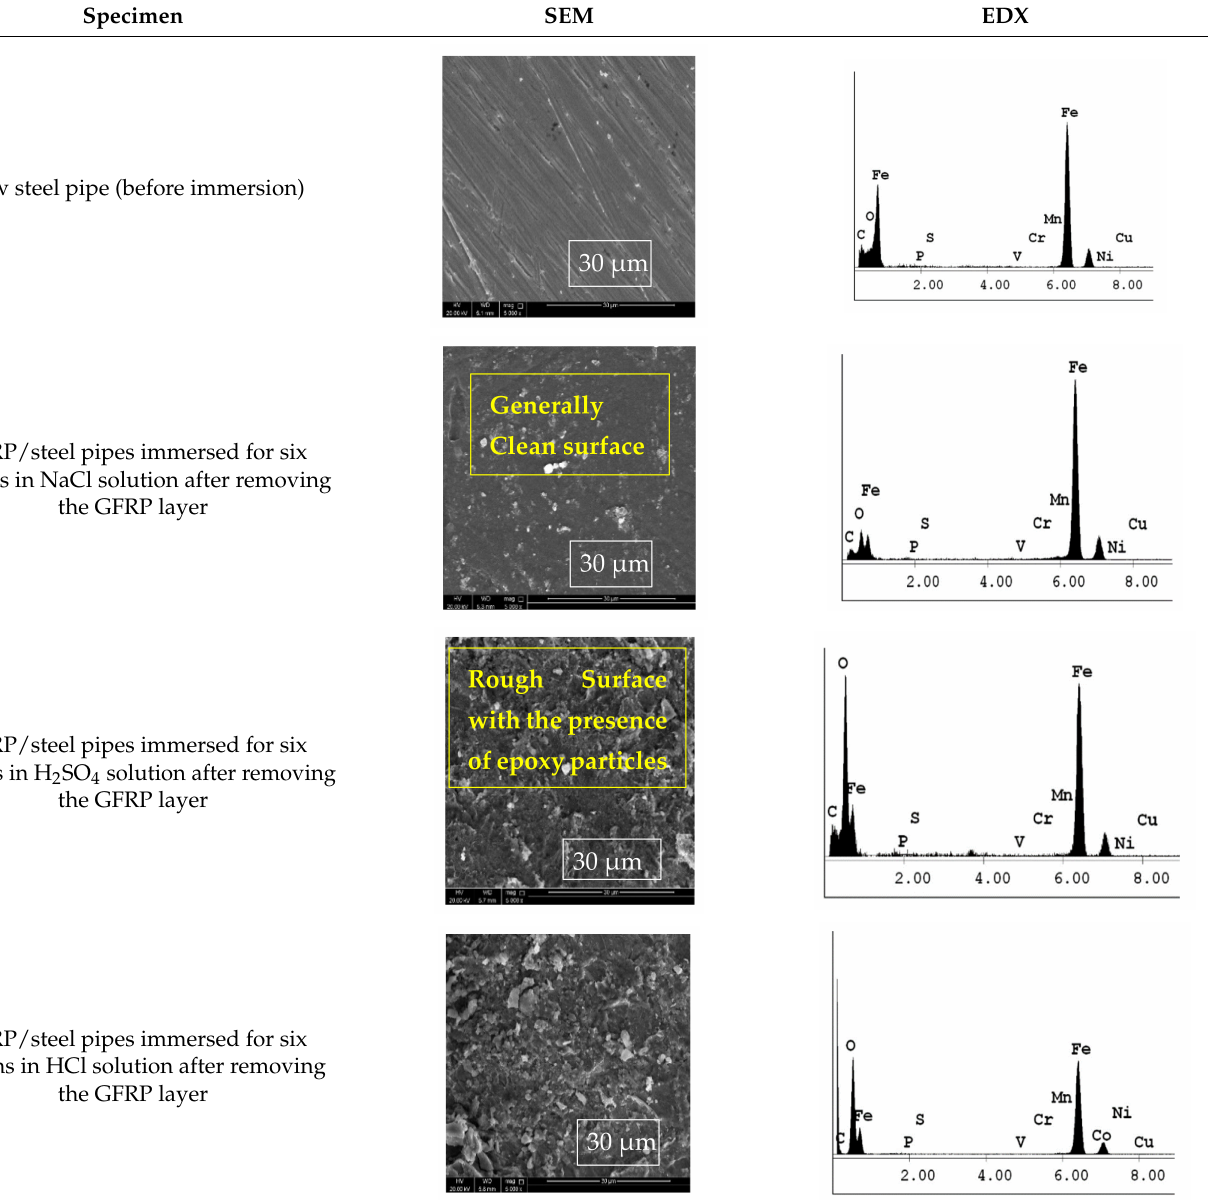
Table 7. SEM images and EDX analysis for the immersed specimens before and after immersion (5000 × magnification).